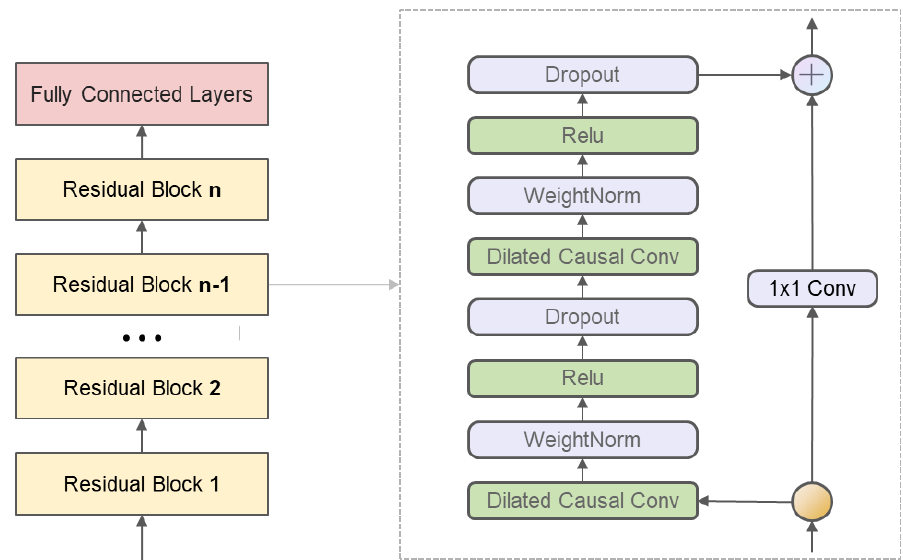
Figure 2. Temporal convolutional network model structure and residual block structure.